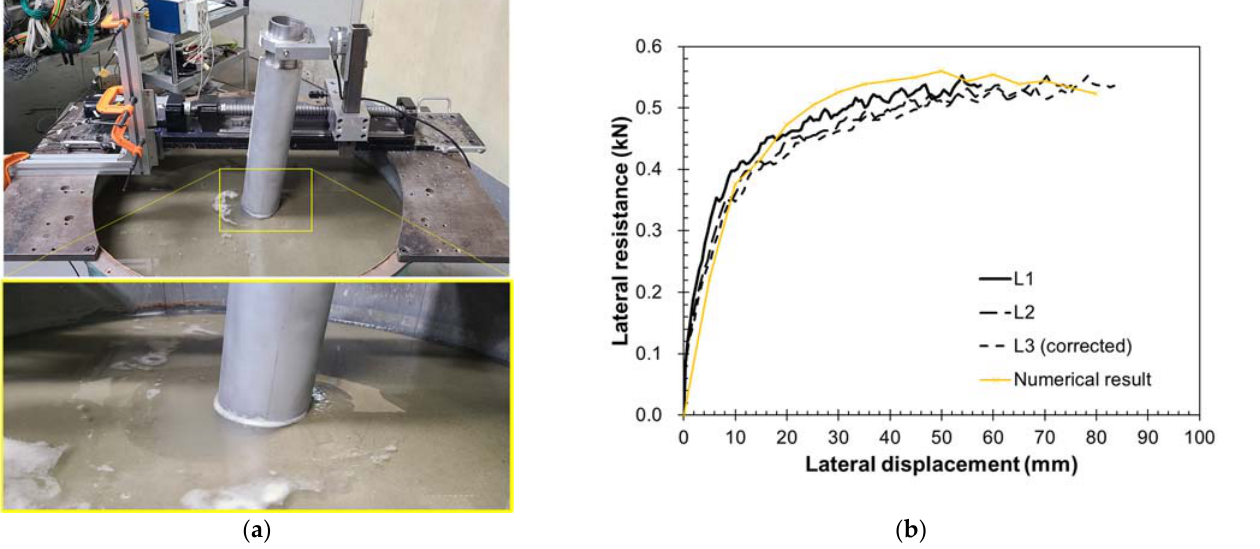
Figure 7. Physical and FE-based test comparison for monopile: ( a ) surface subsidence after loading of physical test; ( b ) load–displacement curves from physical and FE models.